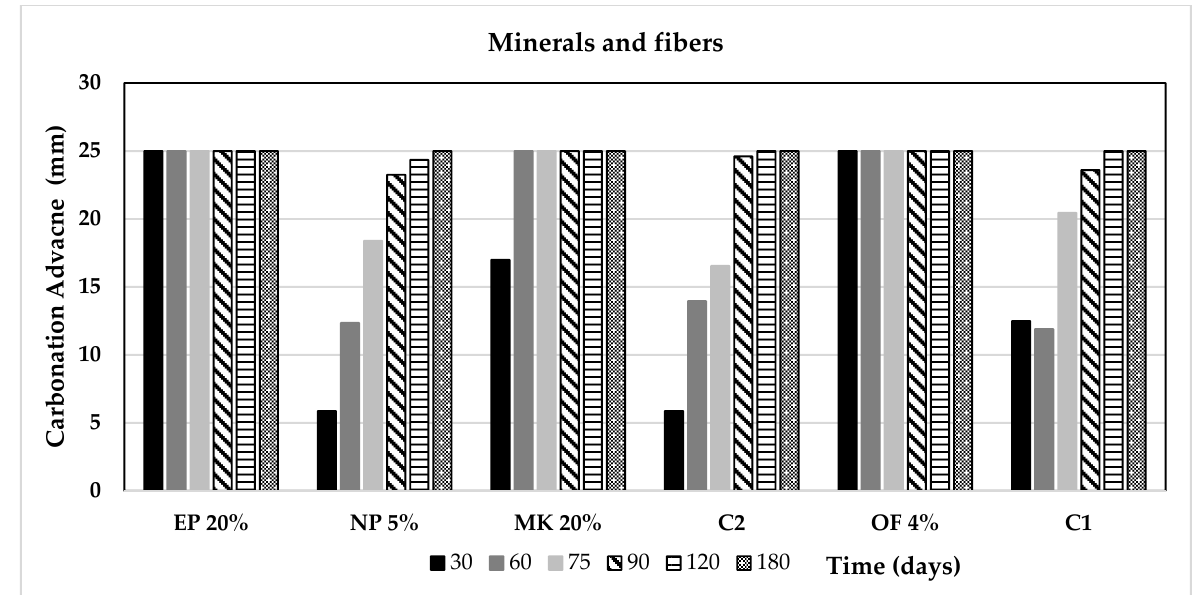
Figure 10. Advance of the carbonation front as a function of the time for the minerals and fibres group of additions.